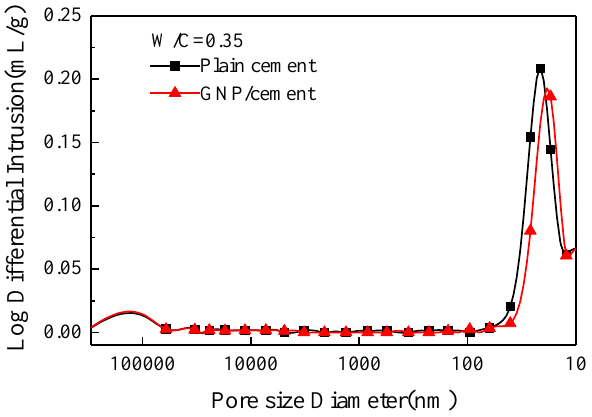
Figure 9. Cumulative pore area vs. pore size diameter: plain cement and GNP–cement composite at 28 days.